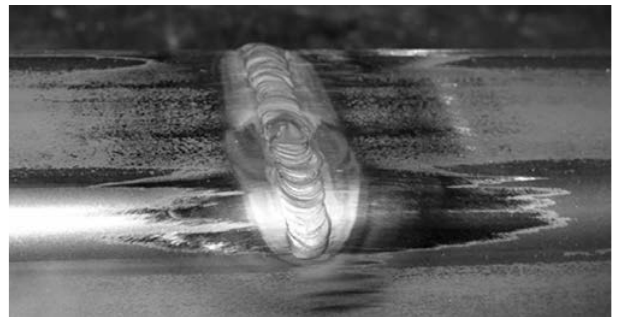
Figure 1. Raised welding bead